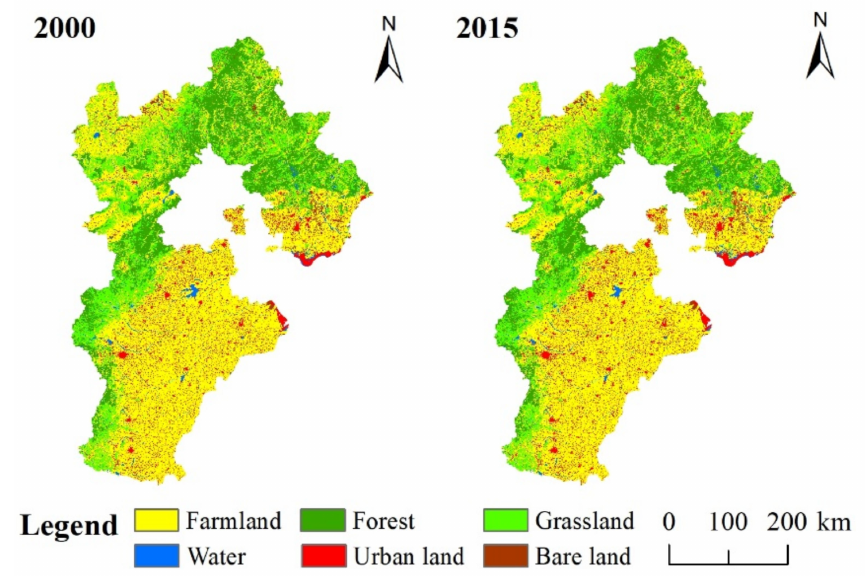
Figure 2. Land-use type of Hebei from